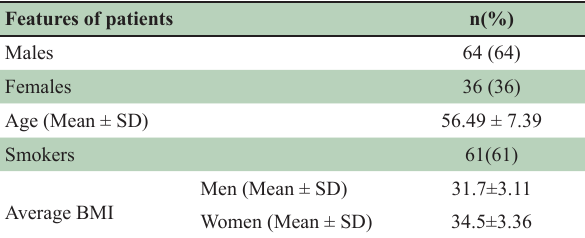
Table-I: General characteristics of patients.